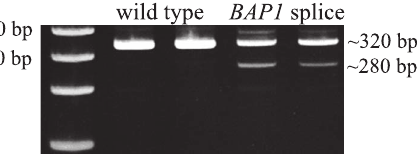
Figure 3. RT-PCR showing the aberrantly spliced BAP1 tran- script. From the left, the first lane shows a size marker, the next two lanes show wild type BAP1 RT-PCR products, and the last two lanes show the aberrantly spliced product resulting from the c.581-2A . G mutation.